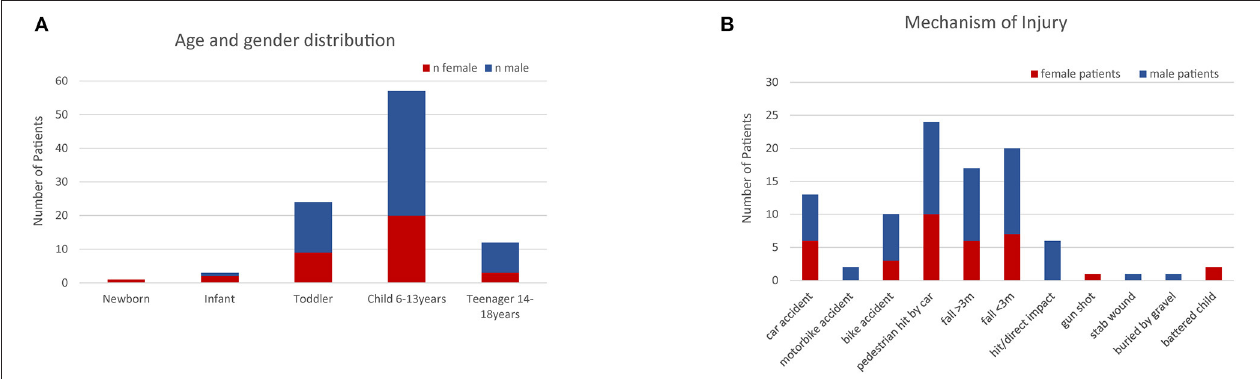
FIGURE 1 | (A) Age and gender distribution of the patients included in the study. (B) Mechanisms of injury. The most frequent cause of polytrauma in this study were traffic accidents and falls.